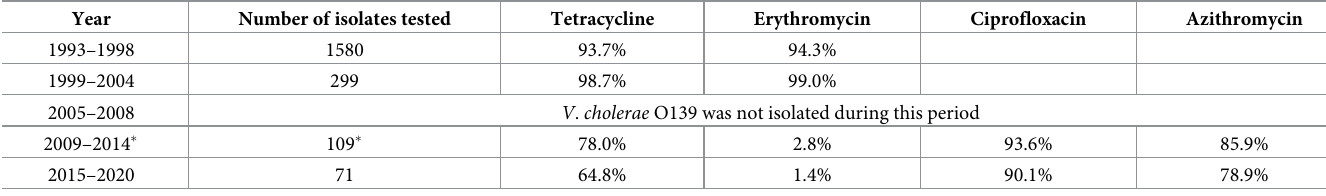
Table 5. Percentage of V . cholerae O139 susceptible to tetracycline, erythromycin, ciprofloxacin and azithromycin during the period, 1993 to